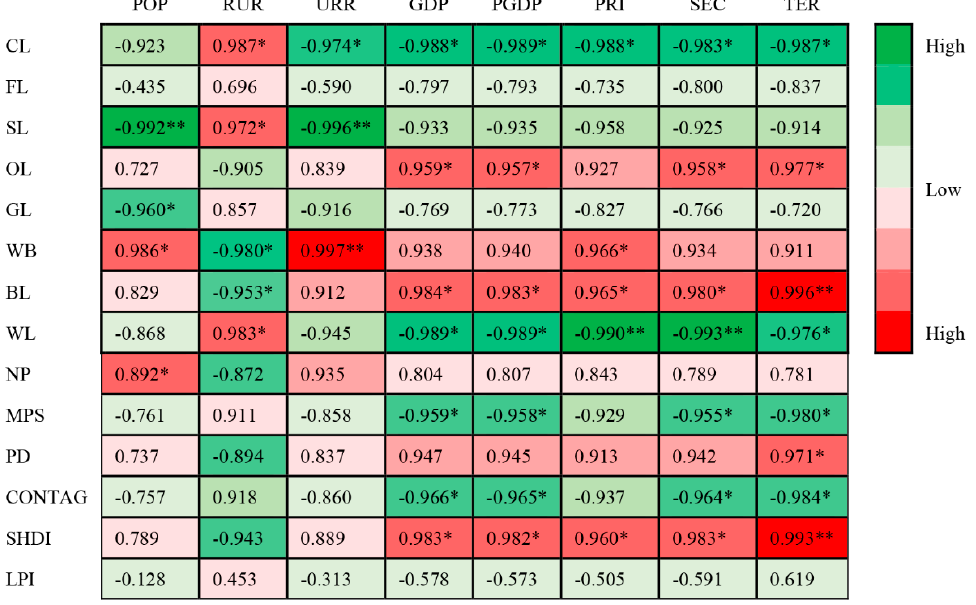
Figure 9. Correlation of land use, landscape patterns and other factors in the MRYRR from 1999 to 2015. Green represents negative relationships and red represents positive relationships. The lighter the color, the weaker the correlation. The data in the frame represents the correlation coefficients between land use types. * Means that p less than 0.05; ** means that p less than 0.01. Details of the abbreviations are shown in Table A1.